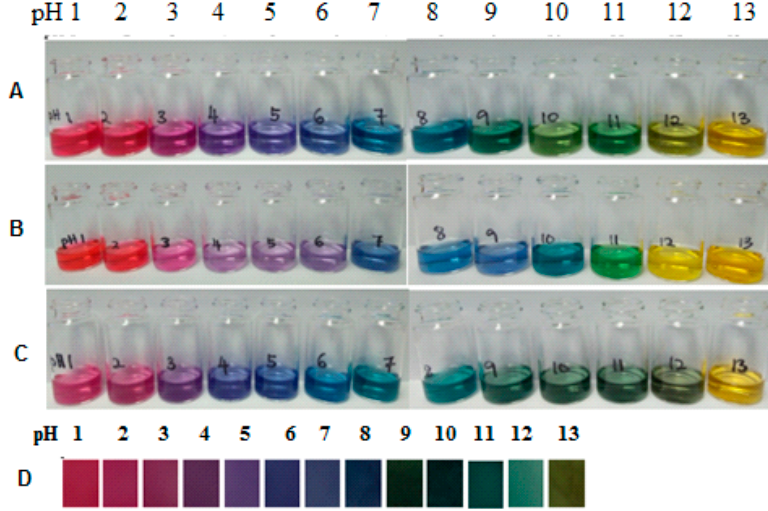
Figure 1. The color of solutions of ( A ) mixed natural dye ( Brassica sp + Clitoria sp); ( B ) Brassica sp; ( C ) Clitoria sp extract) and ( D ) Colorimetric pH sensor film in different pH buffers solution (pH 1–13).